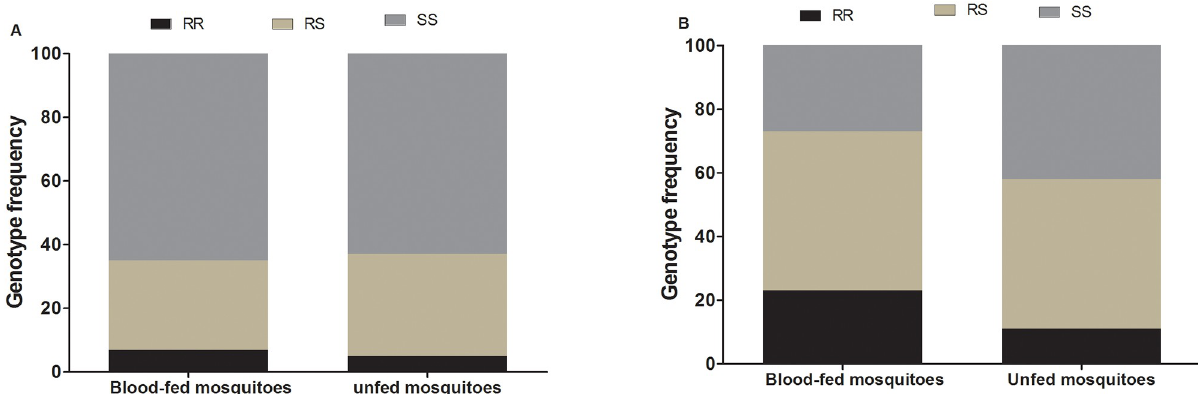
Fig 2. Association between resistance markers and bloodfeeding. Distribution of L119F-GSTe2 (A) and CYP6P9a-R (B) genotypes between blood-fed and unfed An . funestus mosquitoes.